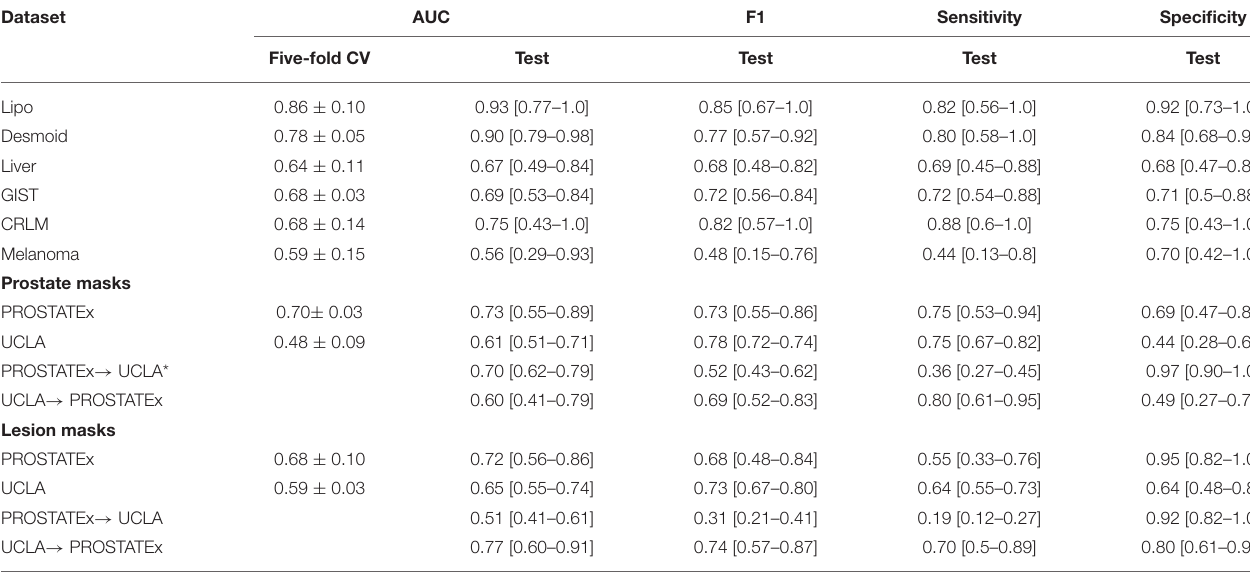
TABLE 2 | Classification